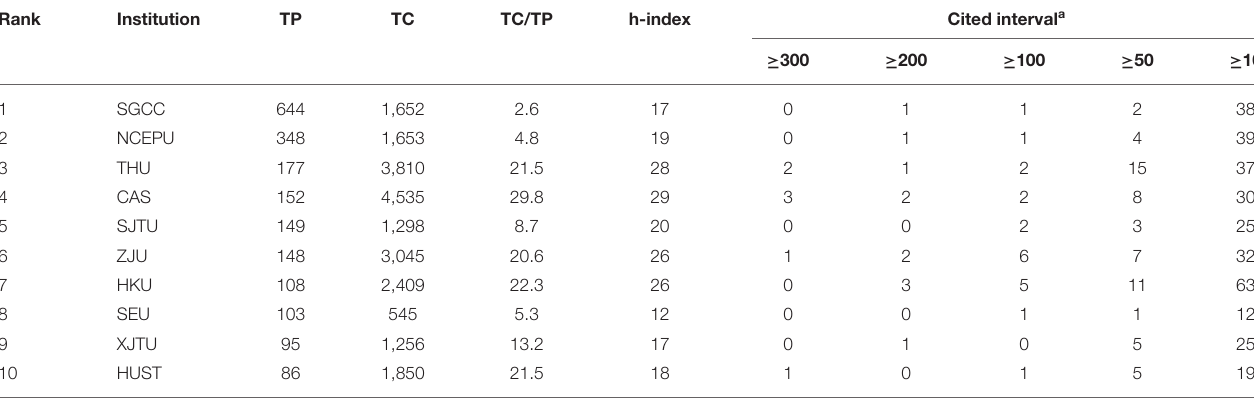
TABLE 2 | Most productive Chinese institutions on